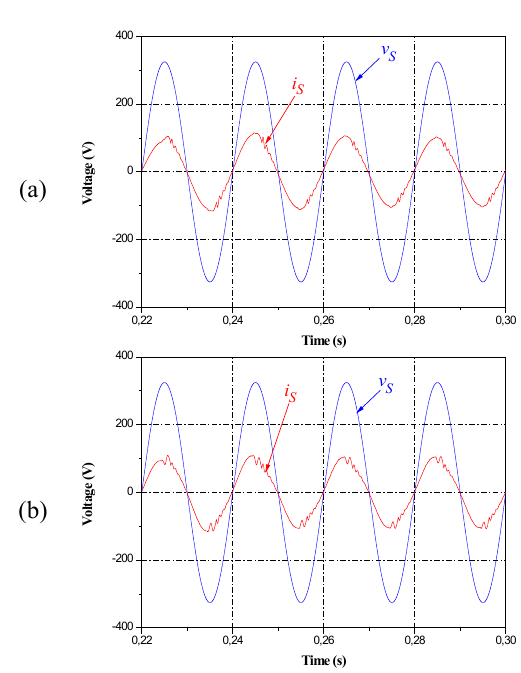
Figure 8. Simulation results of the power grid voltage, v S , and source current, i S , after compensation: (a) Conventional SAPF; (b) Proposed SAPF with reduced dc-link. Table 2. Comparison between the conventional SAPF and the proposed SAPF with reduced